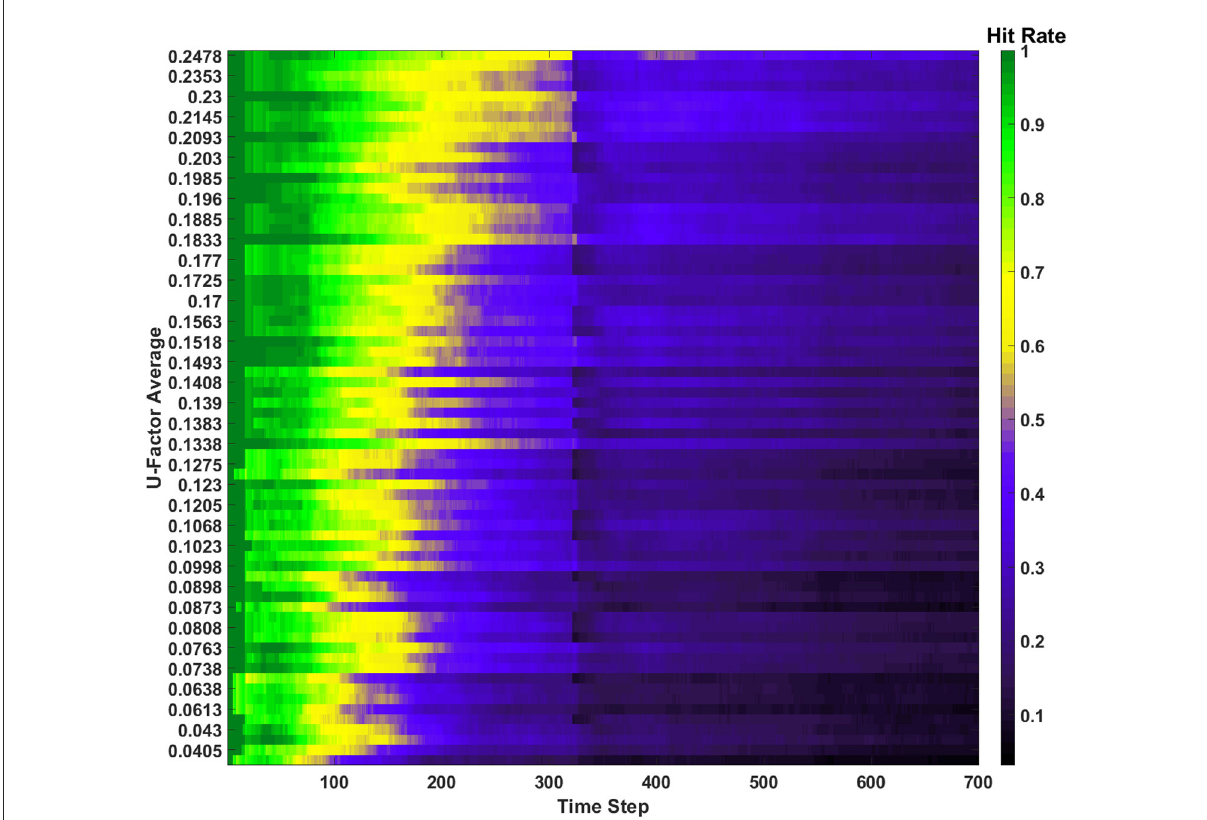
FIGURE11 Hit rate for the behavior ensemble simulation of the SAN. One erasure event occurs, after which the post erase recovery is removed due to the forgetting behavior.